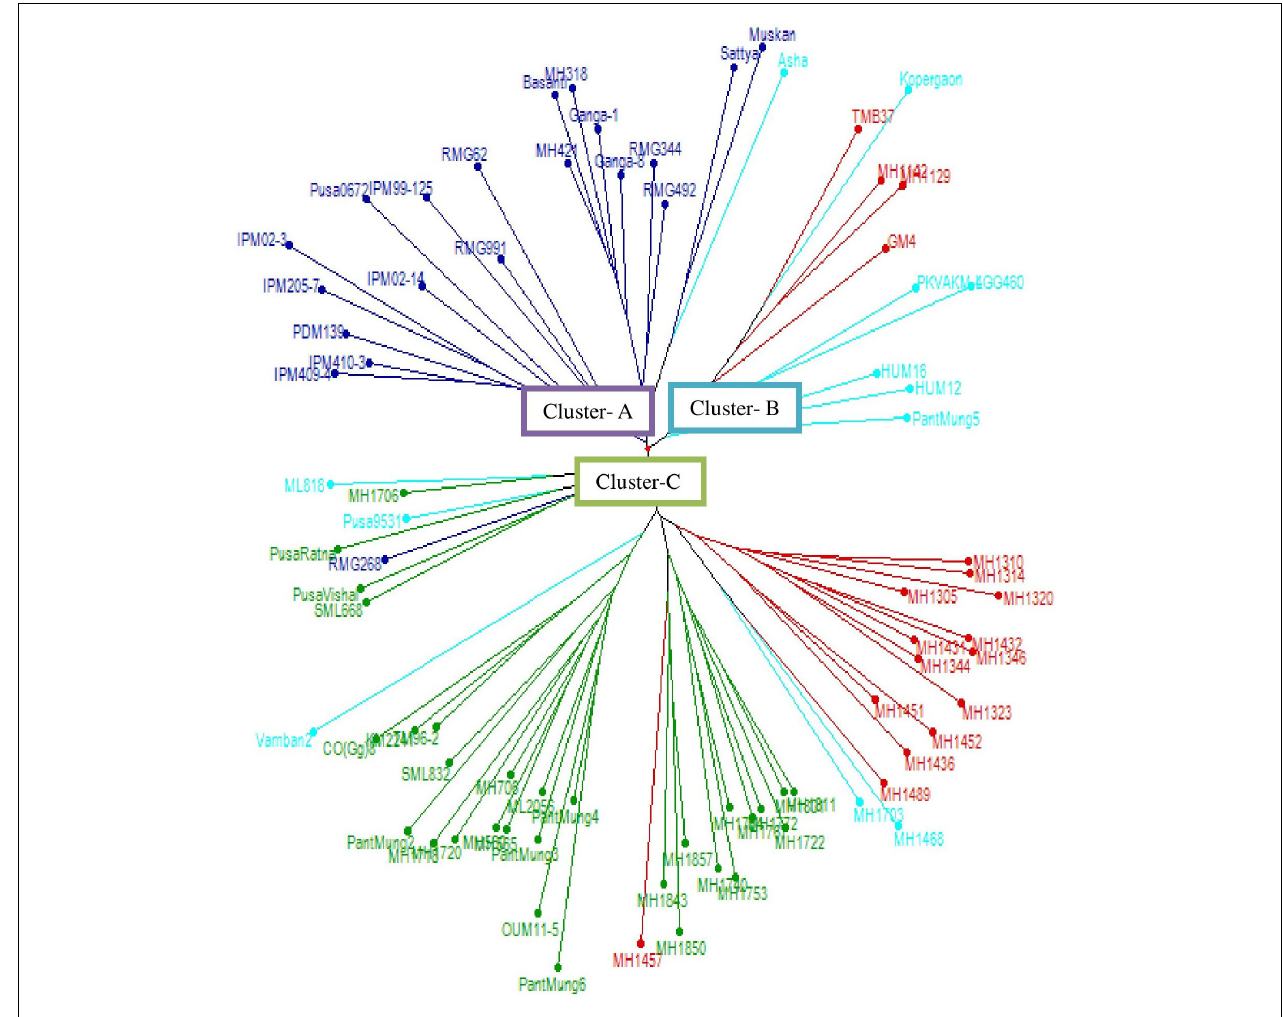
FIGURE 1 | Dendrogram representing the genetic relationship among mung bean genotypes using weighted neighbor-joining (WNJ).